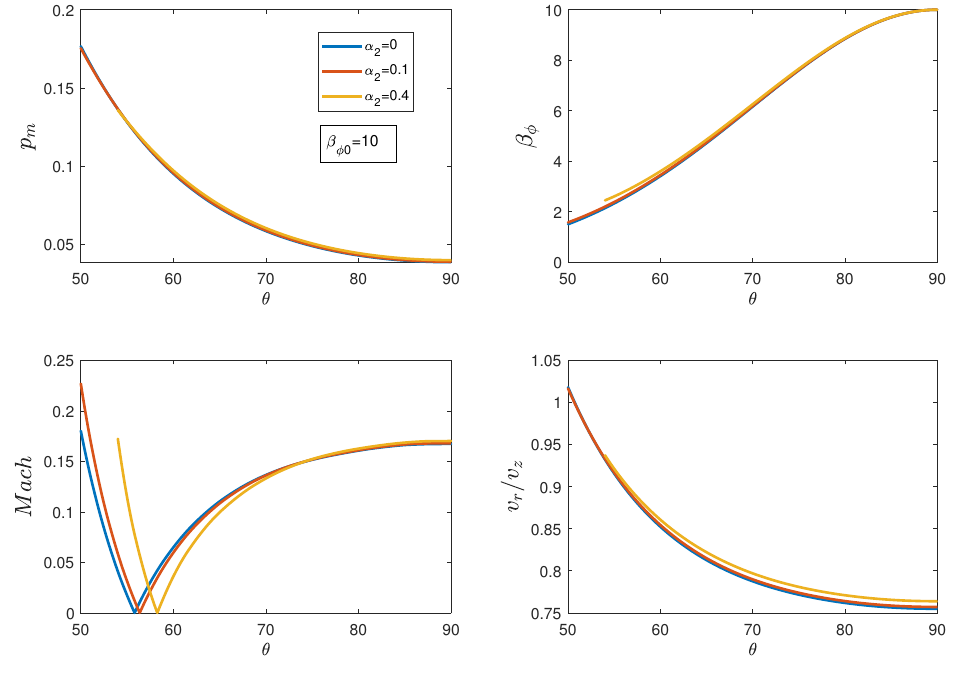
Figure 6. The magnetic pressure ( p m ), the ratio of gas pressure to magnetic pressure ( β φ ), Mach number ( | v r / c s | ), and v r / v z change with θ . Here, the gas pressure is 10 times larger than the magnetic pressure at the